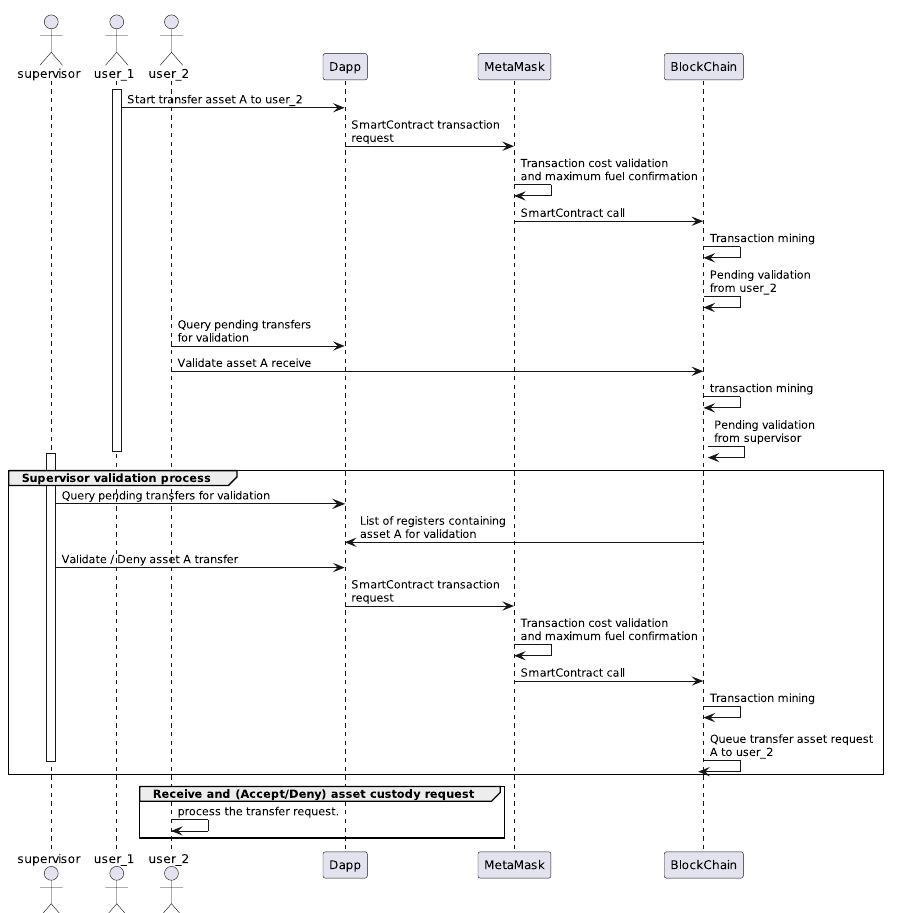
Figure 7. Supervised ownership